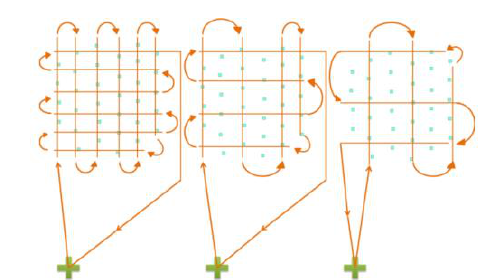
Figure 3. Schematic representation of the movement around the sub-plots - dense, medium, and sparse area coverage.